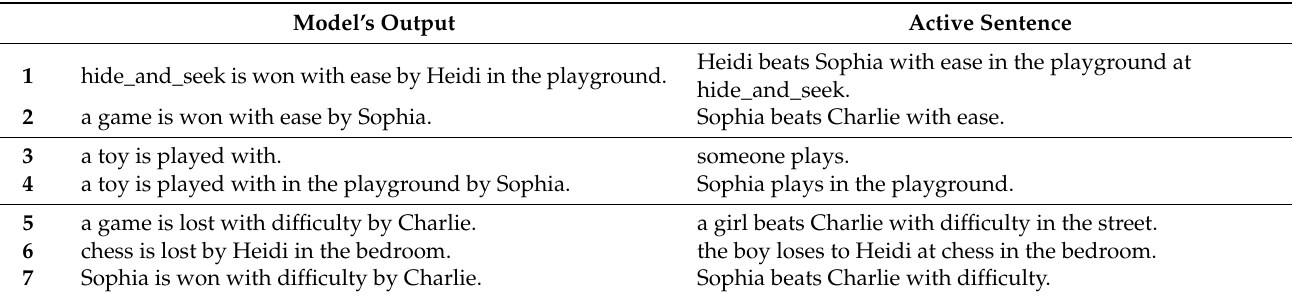
Table 8. Examples of passive output sentences for DSSs with no passive examples. Model’s